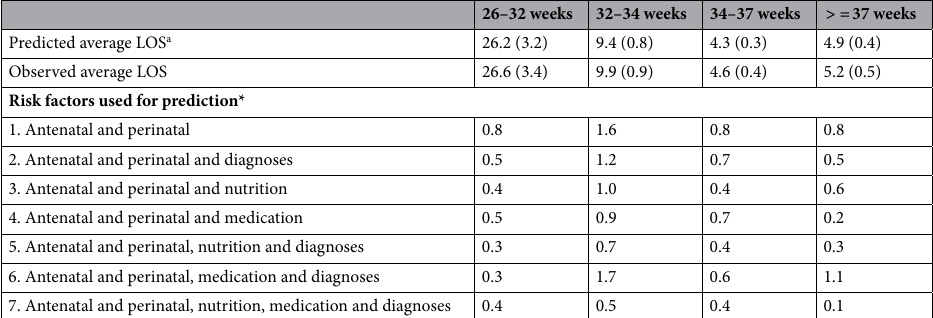
Table 3. Difference between observed and predicted LOS (in days). All values mentioned as “number of days”. a Mean